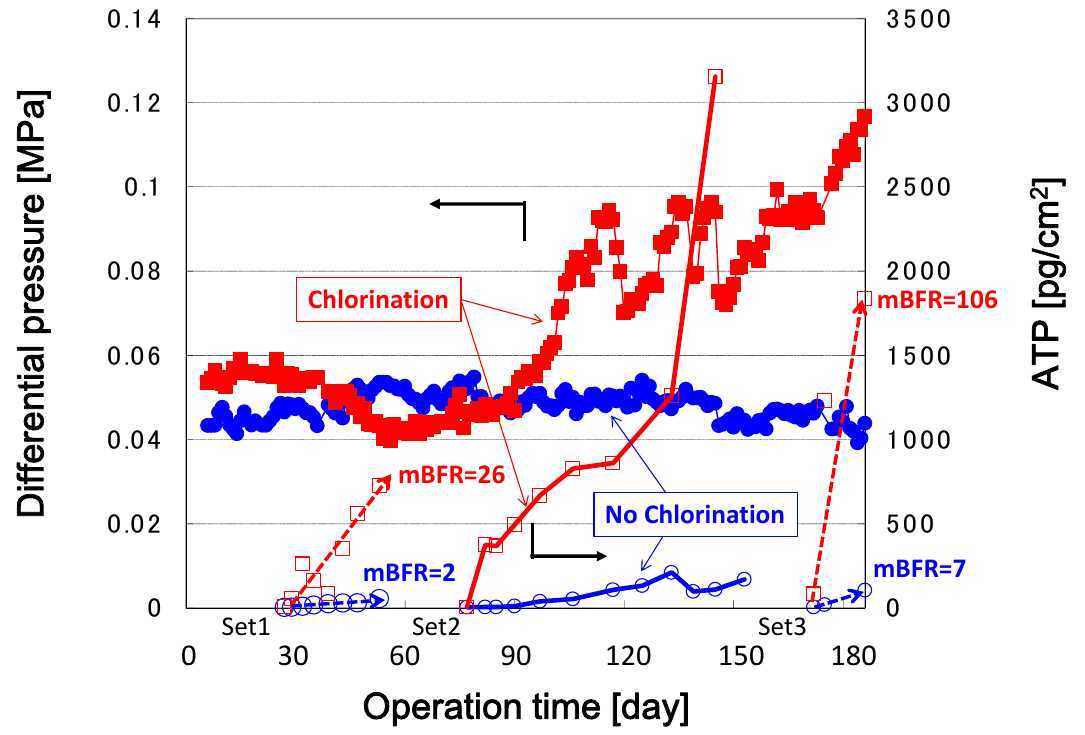
Figure 7. Chlorine sterilization triggers biofouling.